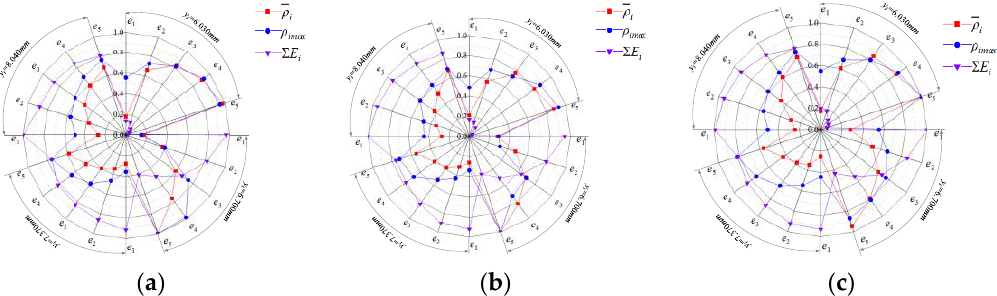
Figure 12. Friction wear energy density distribution of three blades of scheme 2: ( a ) tooth 1; ( b ) tooth 2; ( c ) tooth 3.